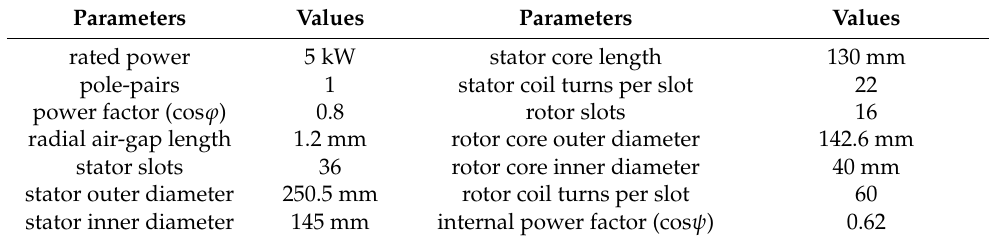
Table 2. Parameters of the CS-5 Prototype Generator.